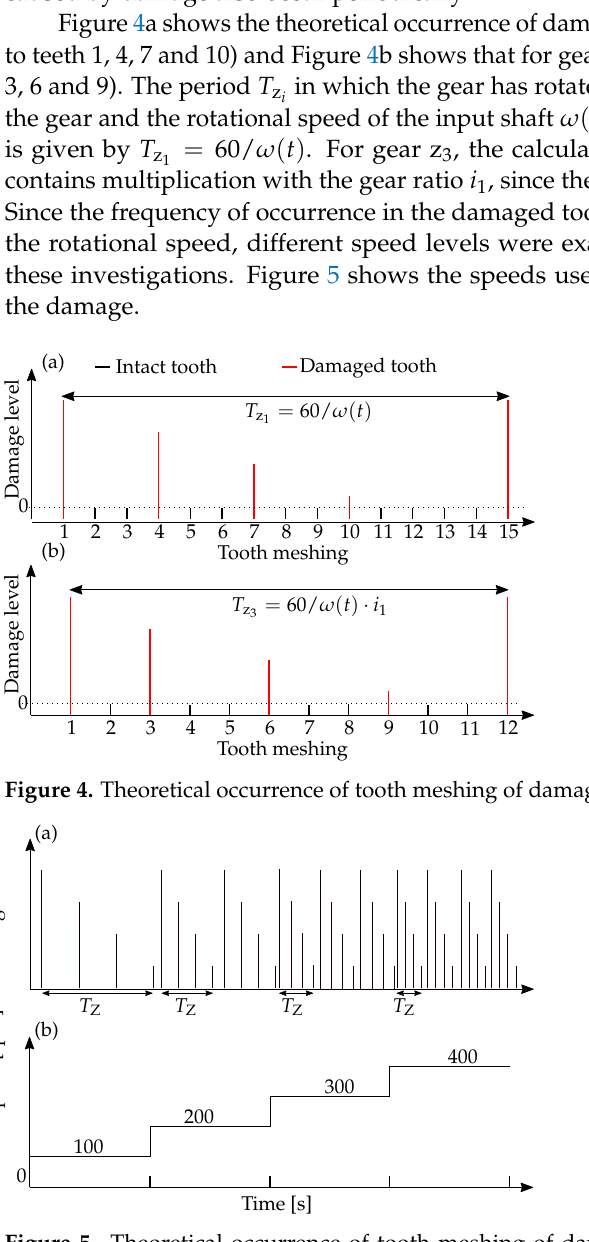
Figure 5. Theoretical occurrence of tooth meshing of damaged teeth ( a ) for different rotational speeds ( b